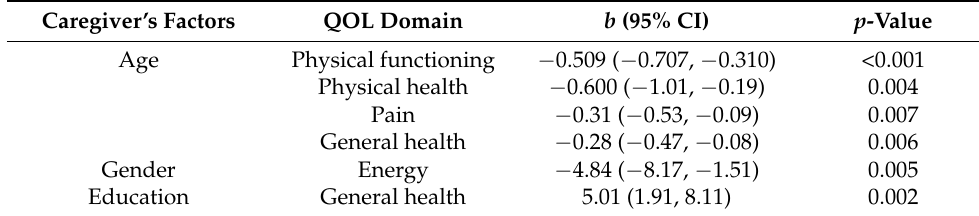
Table 11. Association of caregiver’s sociodemographic factors with QOL based on SF-36 questionnaires. Caregiver’s